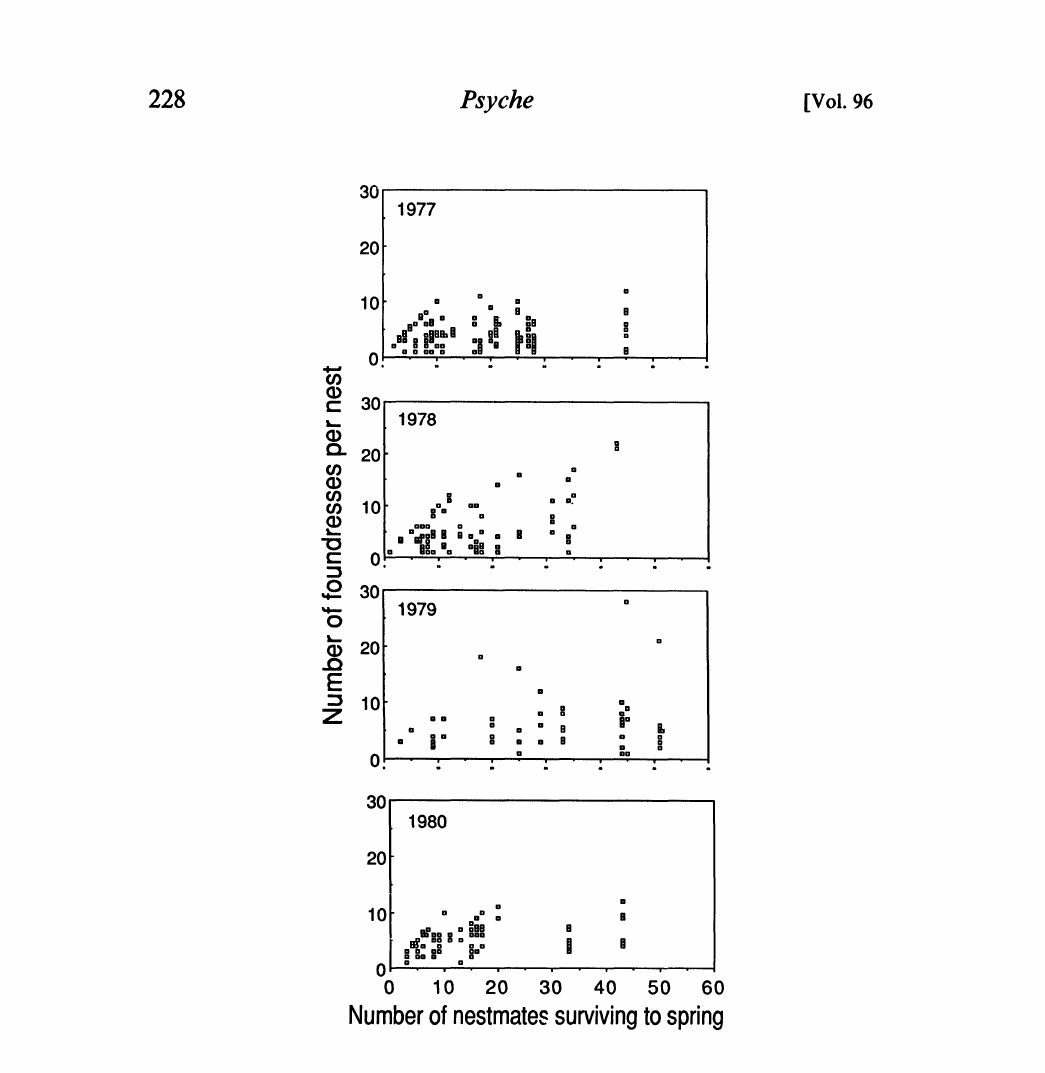
Figure 2. Numbers of foundresses per nest in spring as a function of numbers of nestmates available which is the number of females marked on the same natal nest the previous autumn that survived to spring. Total nests where females were marked the previous autumn are 33 in 1977, 29 in 1978, 13 in 1979 and 30 in 1980 (to match figure, years are given for spring nests, so year of marking is previous year). Correla- tions are not given because all data points are not independent, most natal nests having started multiple new nests. Even if average foundresses per new nest were used, a correlation would still be suspect because one will be forced by the upper limit that the number of foundresses available (x axis) imposes on foundresses per new nest (y